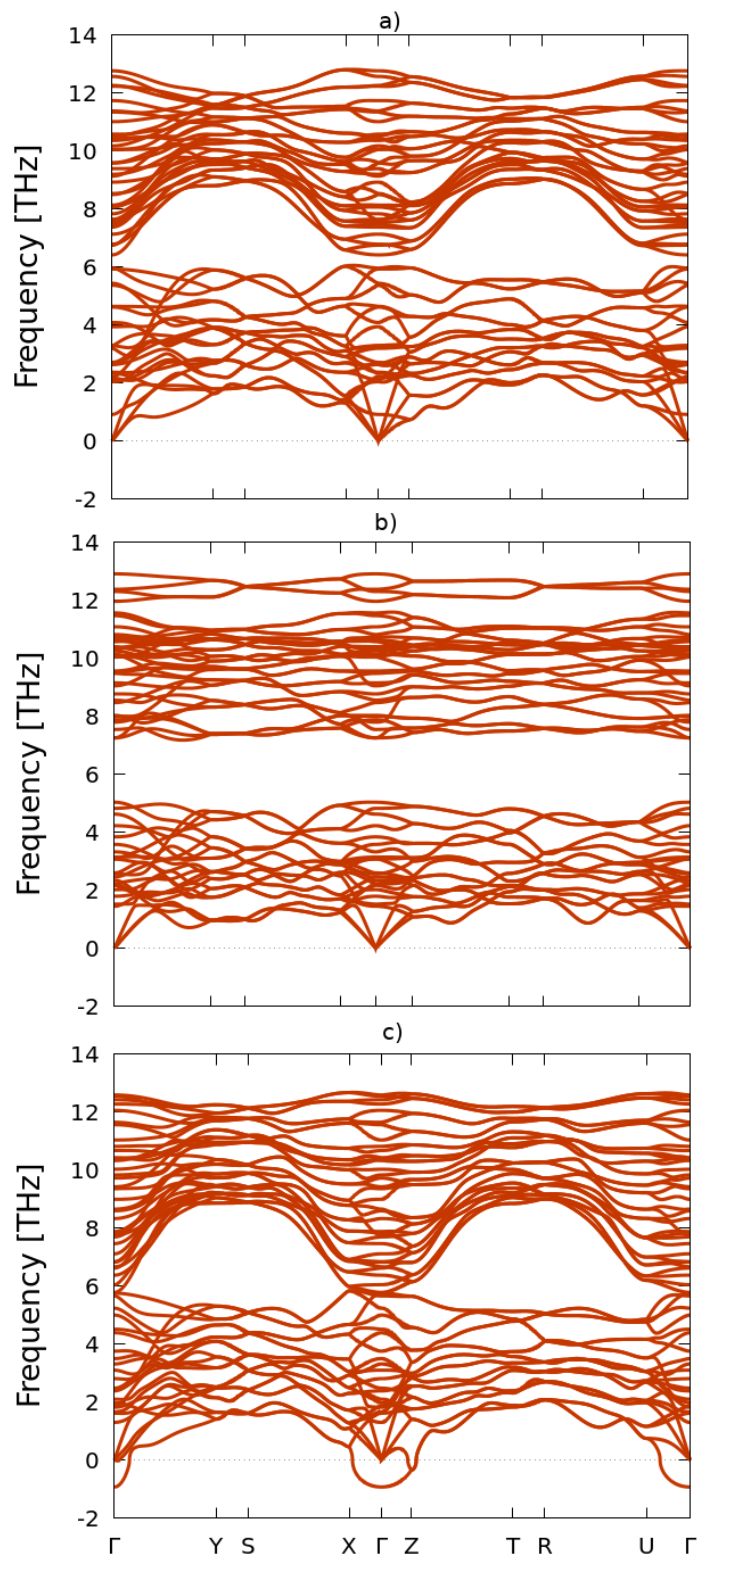
Figure 5. Harmonic phonon dispersion curves of the Pnma phase of Sb 2 S 3 ( a ), Bi 2 S 3 ( b ), and Sb 2 Se 3 ( c ), calculated at 50